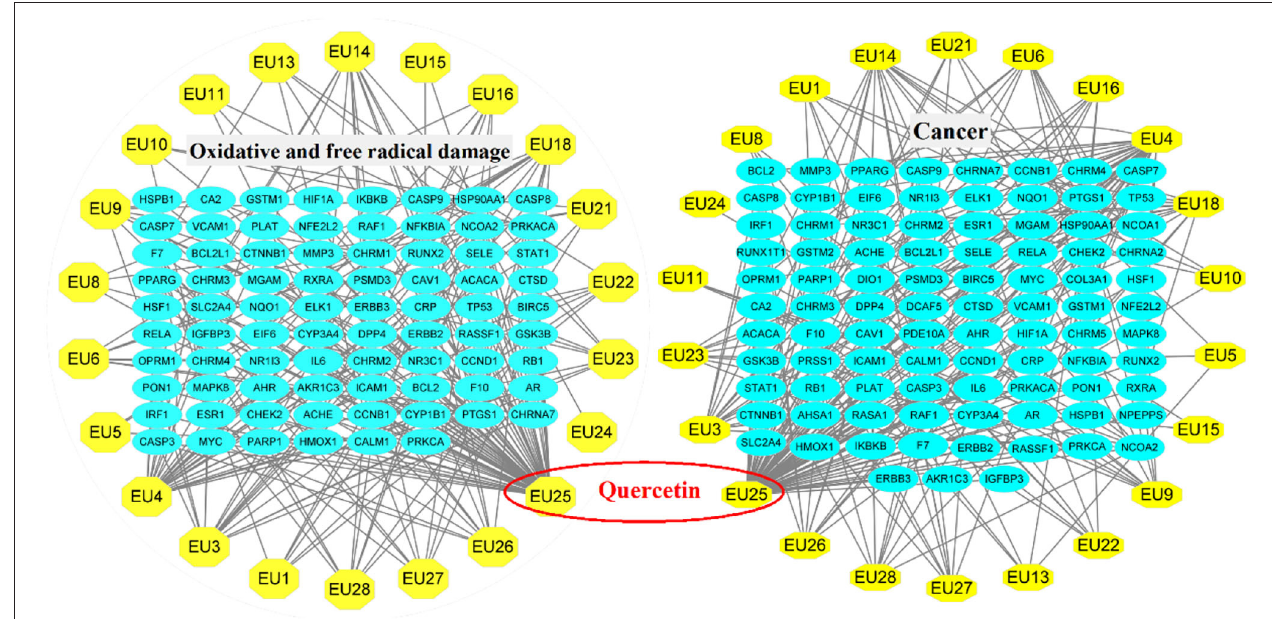
FIGURE 1 | The network of compound-target interactions.